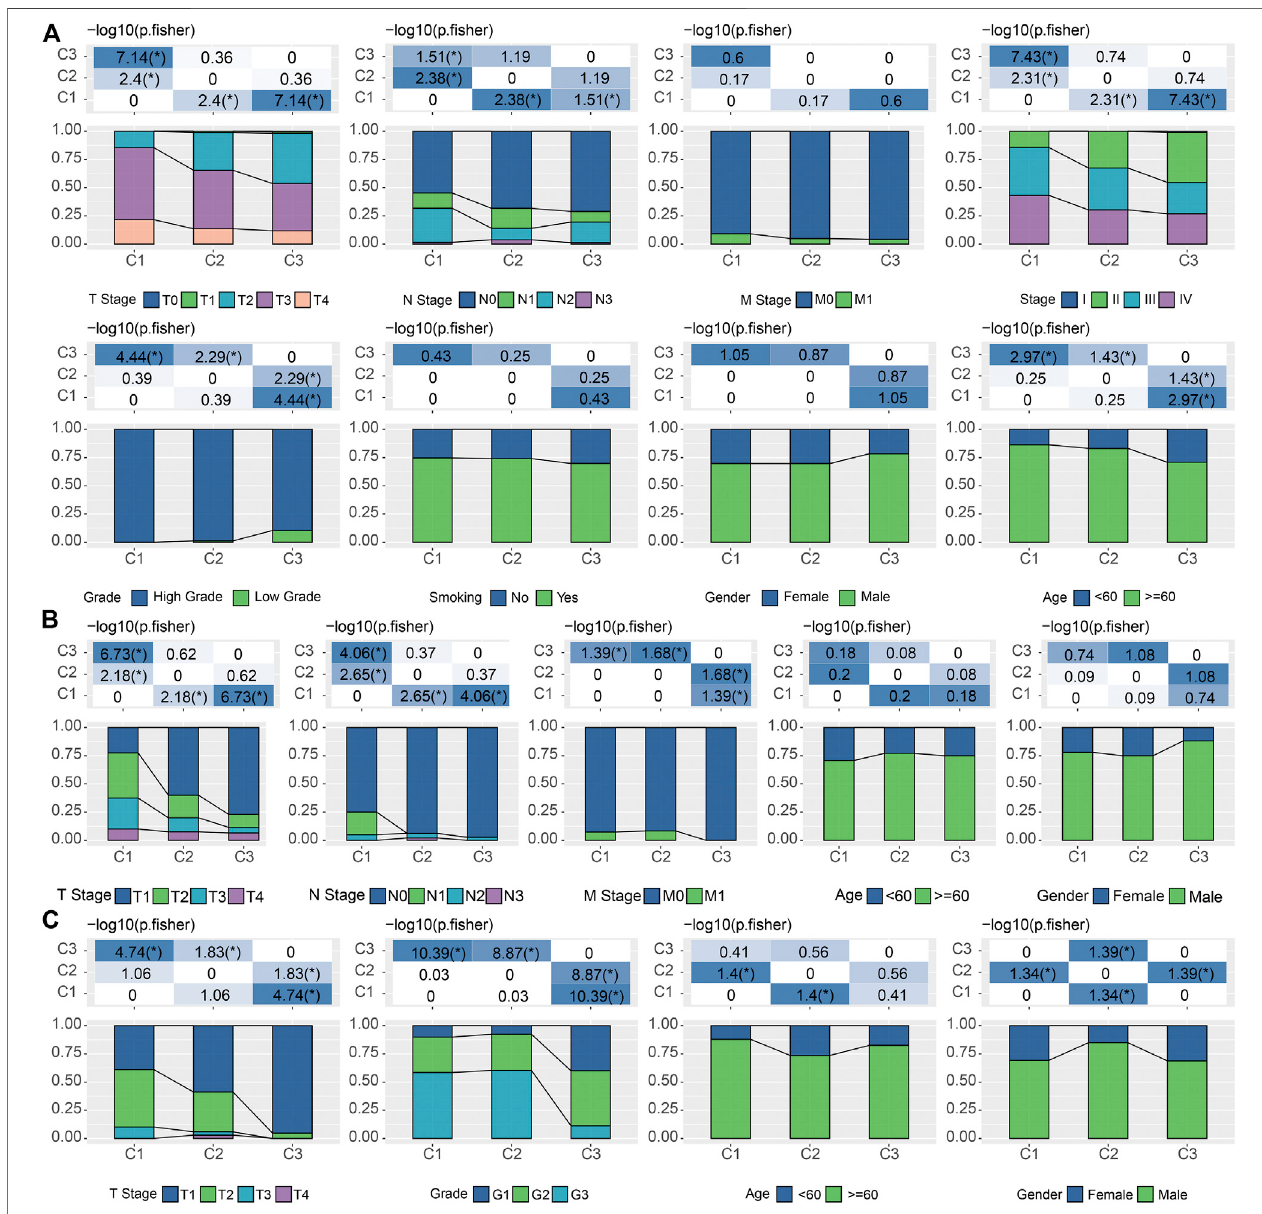
FIGURE3| CorrelationsbetweenLRpairs-basedclustersandclinicalcharacteristics (A) .ThefractionofTstage,Nstage,Mstage,stage,grade,smoking,gender, and age,shown inC1, C2, and C3groups in the TCGA cohort, followed bythe correspondingcomparison ofthe numbers ineach group (Fisher ’ sexact test). * p < 0.05. (B) .ThefractionofTstage,Nstage,Mstage,gender,andage,showninC1,C2,andC3groupsintheGSE13507cohort,followedbythecorrespondingcomparisonof the numbers in each group (Fisher ’ s exact test). * p < 0.05. (C) The fraction of T stage, N stage, M stage, gender, and age, shown in C1, C2, and C3 groups in the GSE32894 cohort, followed by the corresponding comparison of the numbers in each group (Fisher ’ s exact test). * p < 0.05.